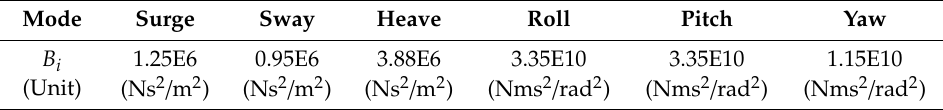
Table 4. Elements of quadratic damping matrix.